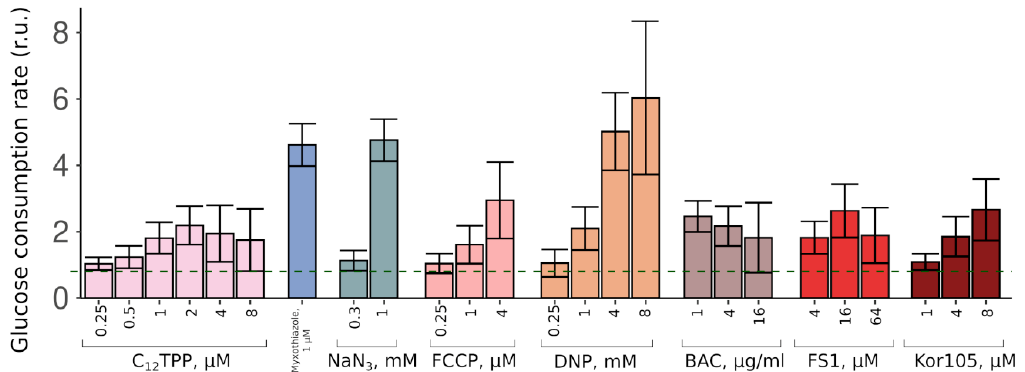
Figure 3. Glucose consumption rates of tps1-delta cells treated with various chemicals (normalized to the control). Error bars correspond to standard deviations; n = 3–8.